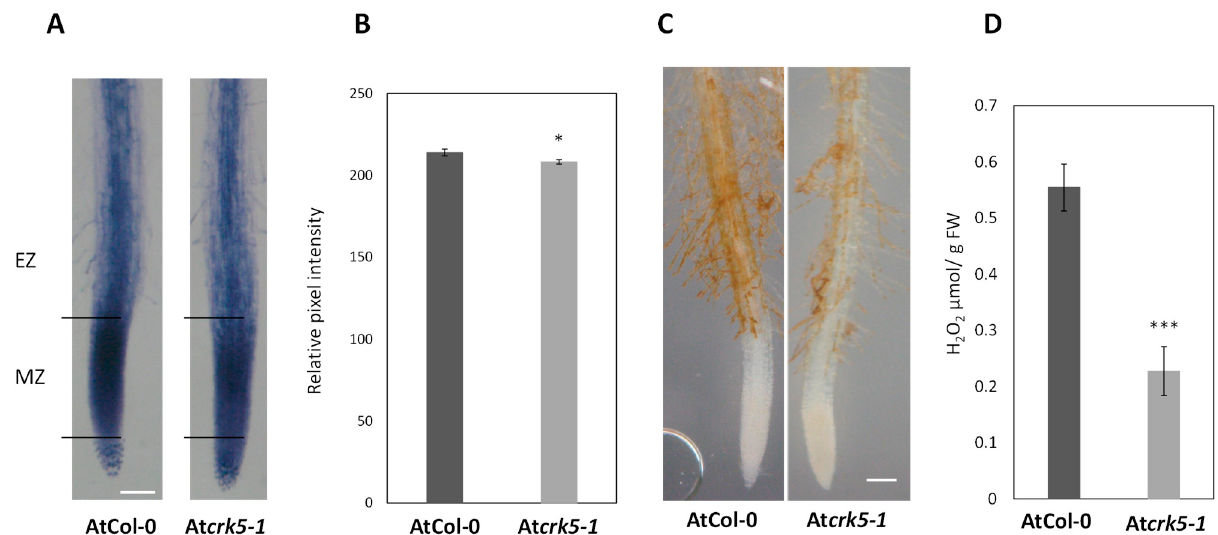
Figure 1. Histochemical staining of ROS in the Arabidopsis roots. ( A ) Superoxide anion staining by nitrosotetrazolium blue (NBT) in the wild type (AtCol-0) and the mutant (At crk5-1 ). Seedlings were grown vertically for 6 days. They were incubated for 5 min in NBT for staining. MZ = meristematic zone, EZ = elongation zone. Bar = 100 µ m. ( B ) Quantification of the NBT content in the root tips of the wildtype and mutant seedlings was based on measuring the pixel intensity of equally sized areas of MZ by ImageJ. Asterisk indicates significant difference between the wild type and the mutant (Stu- dent’s t-test, * p < 0.1). ( C ) Hydrogen peroxide content of the wild type and mutant Arabidopsis roots stained by DAB (3,3 ′ - diaminobenzidine). Seedlings were grown for 10 days then they were incubated in DAB. Representative pictures are shown for each line. Bar = 100µm. ( D ) Hydrogen peroxide content (µmol per gram fresh weight) in wild type and mutant roots was measured spectrophotometrically. Asterisks indicate a significant difference between the wild type and the mutant (Student’s t-test, *** p < 0.001). Measurements were performed with at least 30 seedlings per each line. Bars indicate standard error. Three biologically independent experiments were carried out with the same statistical results.